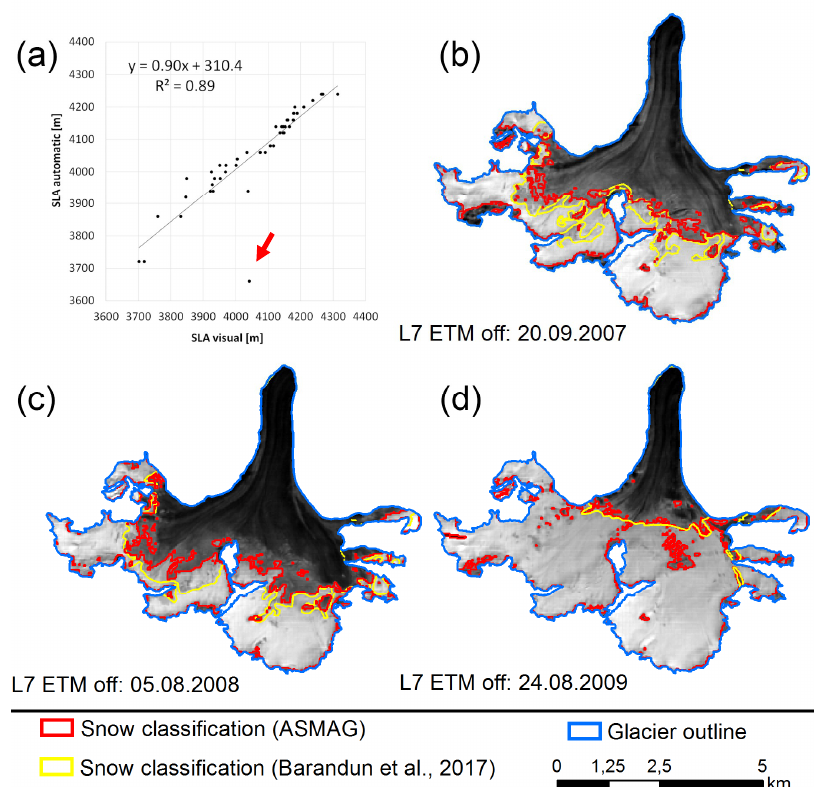
Figure 9. ( a ) Visual versus automatic SLA for Abramov glacier in Kyrgyzstan. As in the Ötztal region, an r 2 of nearly 90% is also obtained. In ( b ), ( c ) and ( d ) a comparison of the ASMAG snow cover classification (red outlines) and the manual digitized SLA (yellow outlines) obtained from Barandun et al. (2017) [59] is shown for three different years.